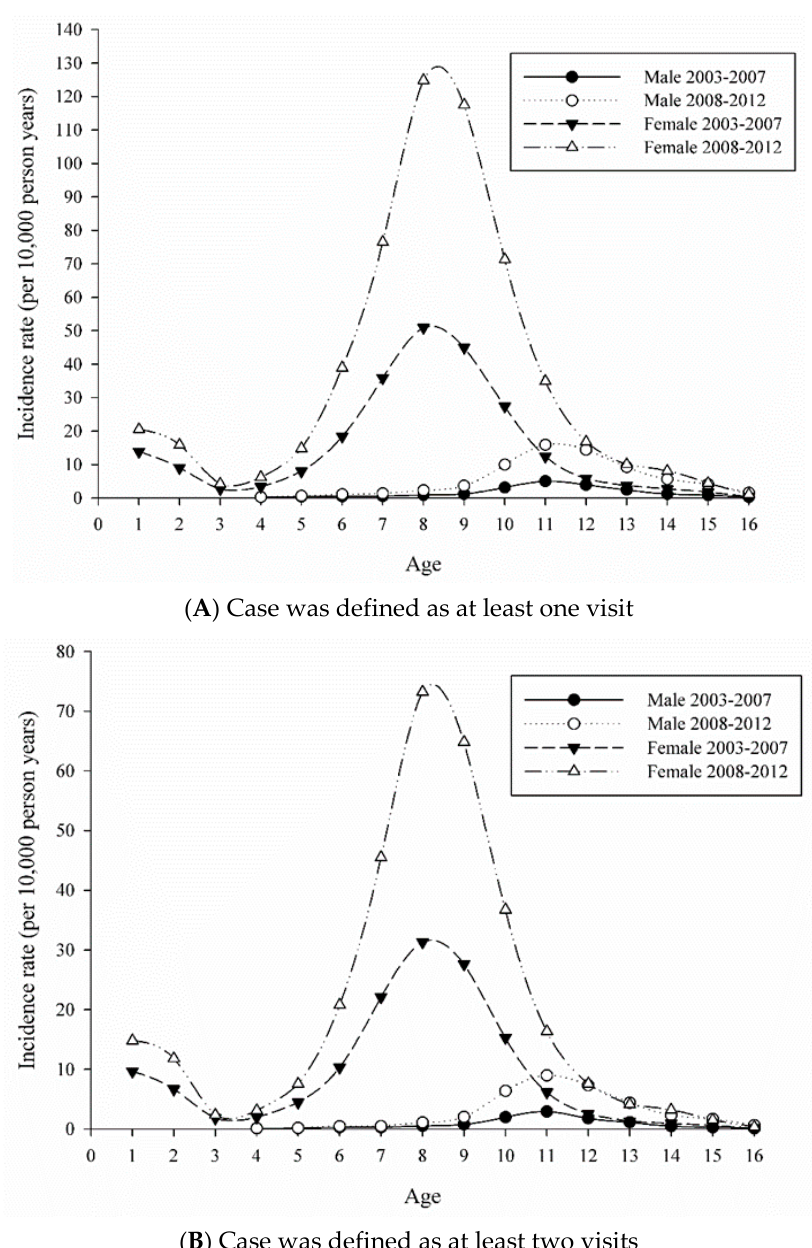
Figure 3. The age-specific incidence of PP in Taiwan by outpatient visit within 1 year from the first diagnosis. ( A ) at least one visit and ( B ) at least two visits.